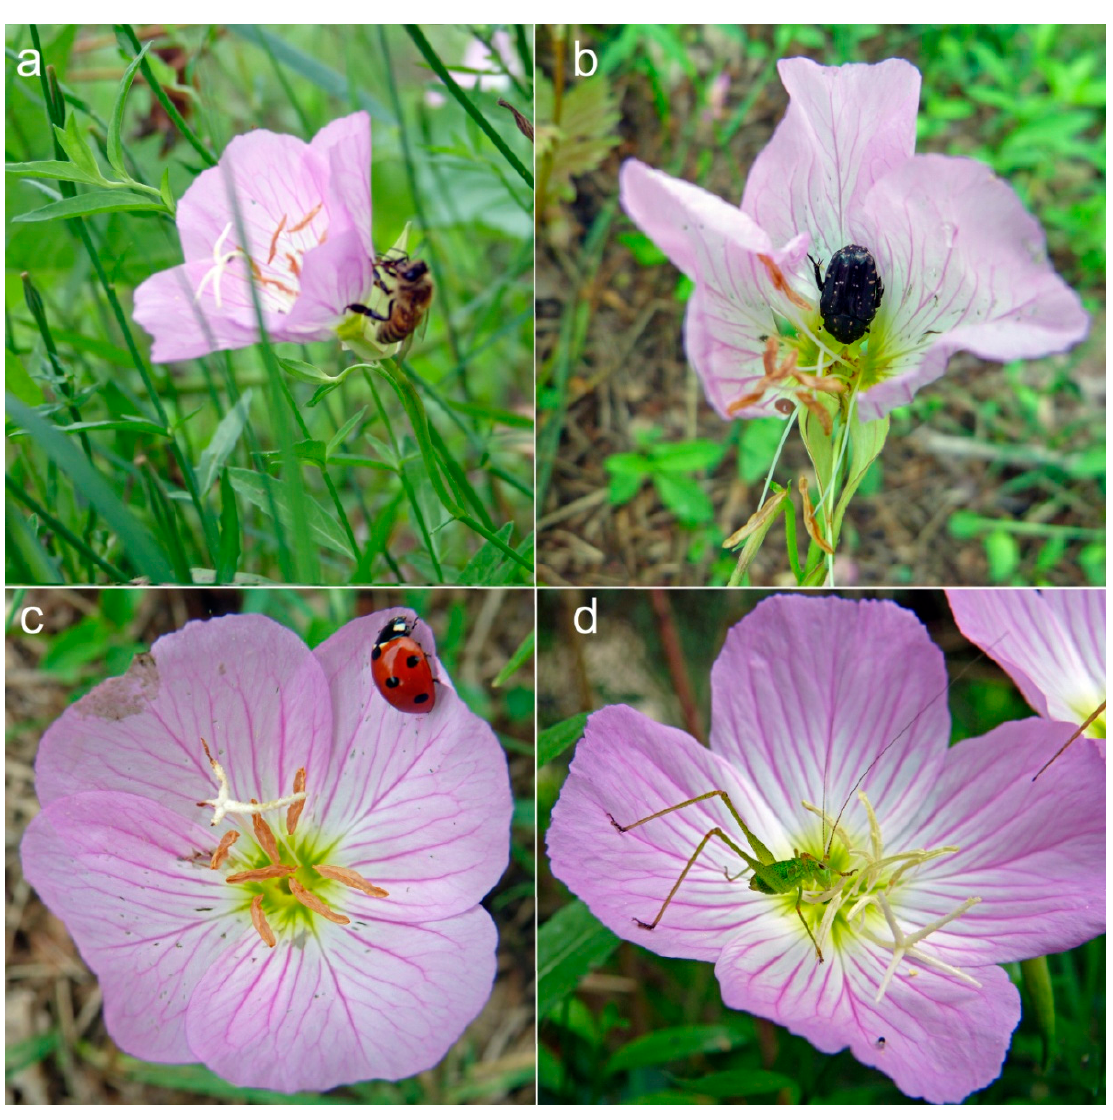
Figure 5. Some insect species visiting the flowers Oenothera speciosa without showing any damage: ( a ) the honeybee Apis mellifera Linnaeus, 1758 (Apidae); the beetles ( b ) Oxythyrea funesta Poda, 1761 (Scarabaeidae) and ( c ) Coccinella septempunctata Linnaeus, 1758; and ( d ) a young katydid (Orthoptera Tettigoniidae). Photo credit: Andrea Bonifazi.